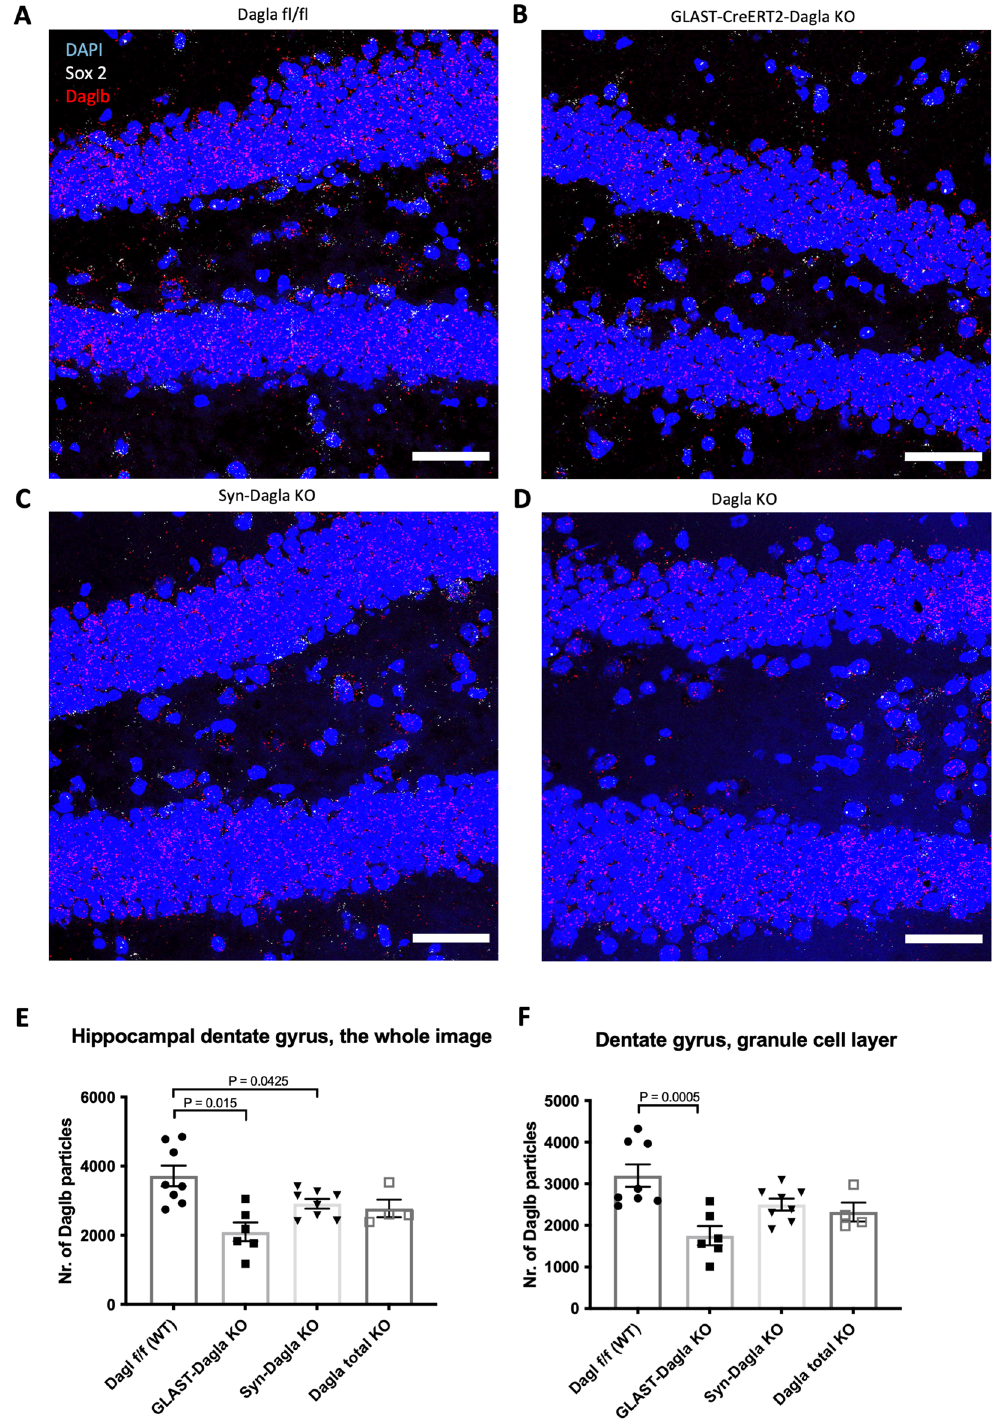
Figure 6. Daglb expression is downregulated in GLAST-CreERT2-Dagla KO mice. Representative 40 × images of an RNAscope in situ hybridisation assay detecting transcripts of diacylglycerol lipase beta Daglb (red) and neural progenitor marker Sox 2 (white) in the dentate gyrus of hippocampus (DG) (scale bar 50 µm) ( A ) in Dagla fl/fl control mice, ( B ) in GLAST-CreERT2-Dagla KO with a deletion in astrocytes and neuronal progenitor cells, ( C ) in constitutive neuronal Syn-Dagla KO animals, and ( D ) in total Dagla KO mice. Quantification of Daglb particle count at Bregma − 1.70 mm ( E ) in the whole hippocampal DG region (including the granule cell layer, the hilus/polymorph layer of DG, and the molecular layer of DG) (F 3,22 = 7.522, p = 0.0012) and ( F ) only in the granule cell layer that consists mostly of neurons (F 3,22 = 7.256, p = 0.0015). Values represent mean ± SEM; n = 2–4 animals/group; 2 pictures analyzed per animal. 1-way ANOVA with Dunnett’s multiple comparisons